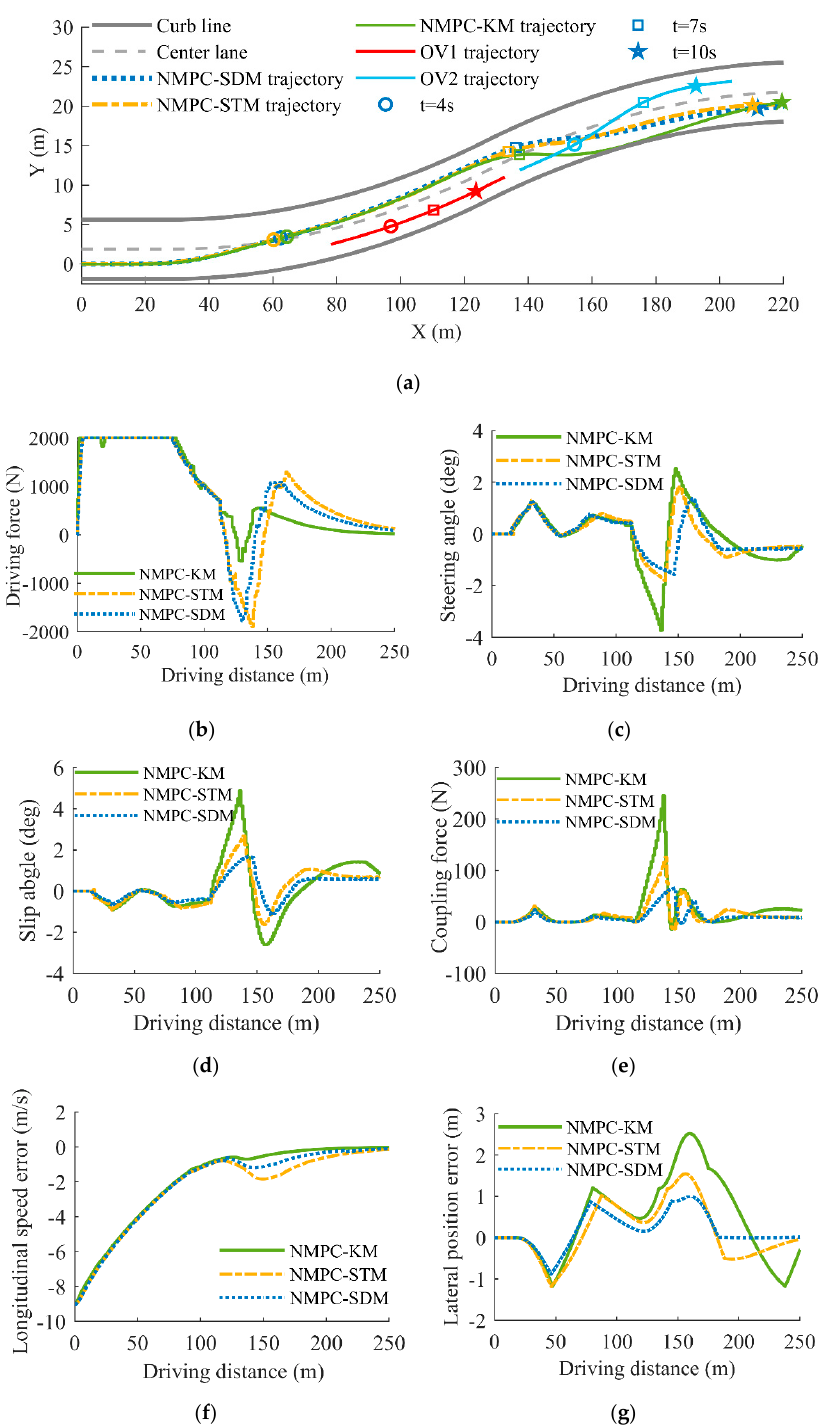
Figure 15. Simulation results under Scenario 2: ( a ) vehicle trajectories; ( b ) longitudinal driving force; ( c ) steering angle; ( d ) slip angle of tire; ( e ) longitudinal coupling component of lateral force; ( f ) longitudinal speed error; ( g ) lateral position error.